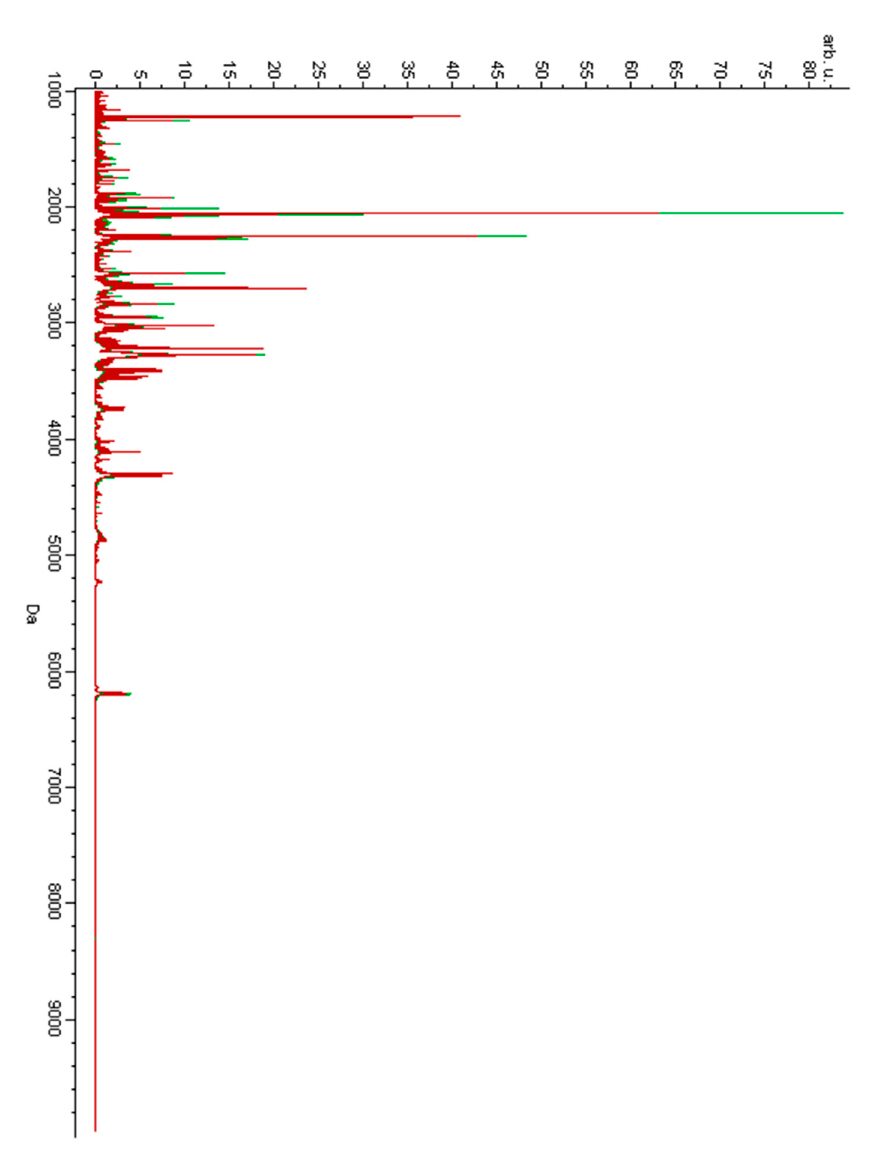
Figure 1. Average MALDI-TOF mass spectra of urine samples of the women suffering from gestational trophoblastic neoplasm (GTN) before treatment (red) and of the pregnant controls (green) over the full scan range of m/z 1000–10,000.